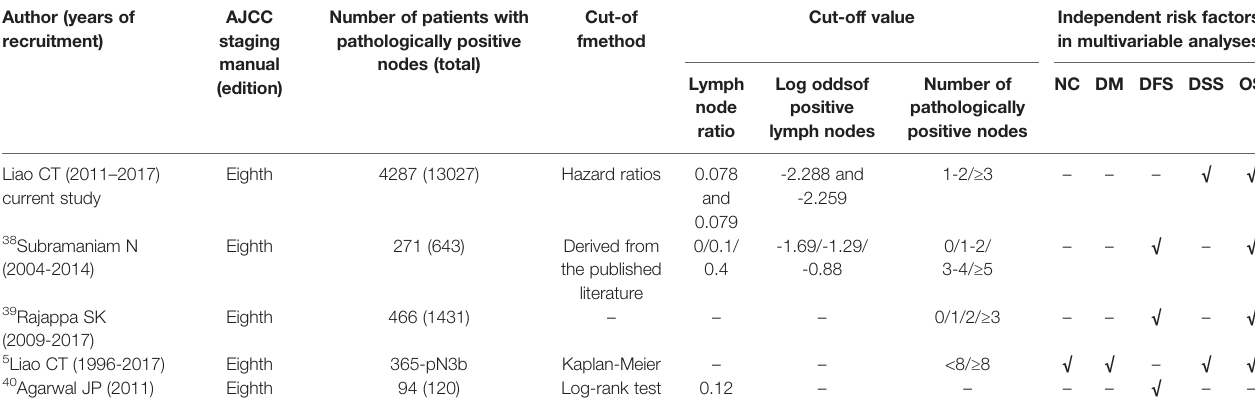
TABLE 3 | Published literature focusing on the prognostic signi fi cance of lymph node ratio, log odds of positive lymph nodes, and/or number of pathologically positive nodes according to the AJCC 2017 staging system (eighth edition). Author (years of